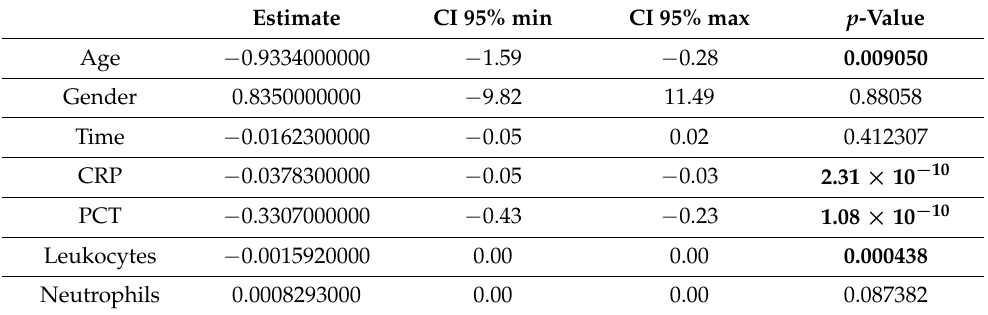
Table 4. Generalised linear mixed models (GLMM) for evaluating the association between biomarkers and creatinine clearance over time in patients with lung infection.